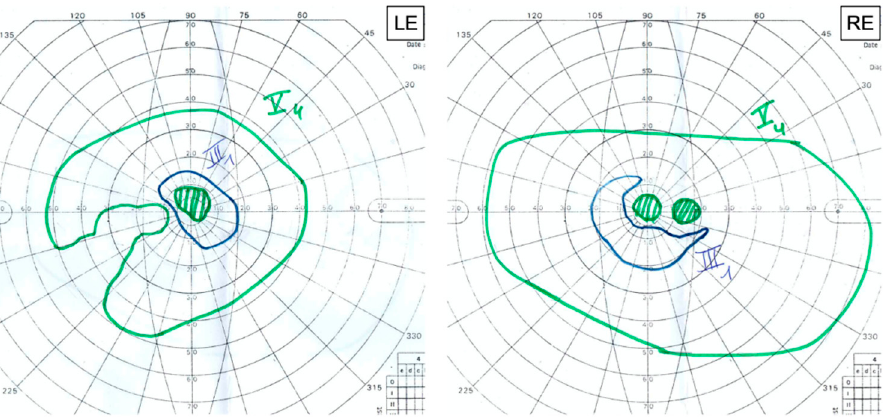
Figure 6. GVF defects of both eyes. Reduced isopters (V4 and III) and central scotomas (V4) in both eyes. Enlarged blind spot (V4) and temporal superior defect excluding the blind spot and the central field (III1) in the RE. Exclusion of the blind spot (V4) in the LE. Full-field electroretinogram (ff-ERG) (Metrovision, Perenchies, France) was within normal limits in both scotopic and photopic conditions. Indeed, the rod response ampli- tude and peak time were within the normal limits in scotopic conditions; oscillatory po- tentials were normal indicating a preserved macular function; photopic response ampli- tude and peak time were within normal limits as well; and finally, a flicker ERG showed regular periodic responses reflecting preserved M- and L-cones function (Figure 7A).